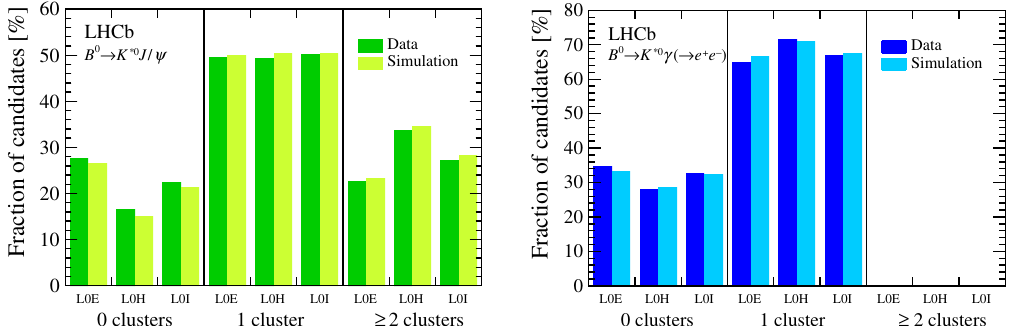
Figure 5 . Fraction of (left) B 0 ! K (cid:3) 0 J= ( ! e + e (cid:0) ) and (right) B 0 ! K (cid:3) 0 (cid:13) ( ! e + e (cid:0) ) candidates (in percent) with zero, one, and two or more recovered clusters per trigger category. The numbers are from (darker colour) data and (lighter colour) simulation. Due to the very low opening angle of the two electrons in B 0 ! K (cid:3) 0 (cid:13) ( ! e + e (cid:0) ) decays, the bremsstrahlung photon energy deposits overlap and only one bremsstrahlung cluster at most is